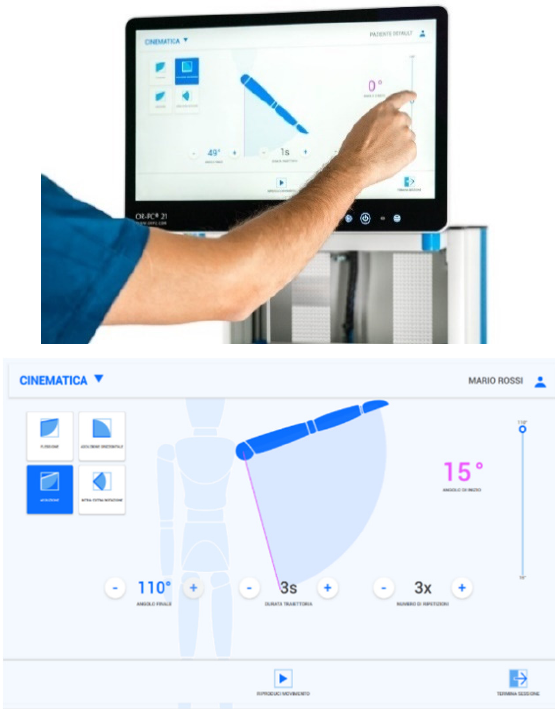
Figure 9. Float graphical user interface.